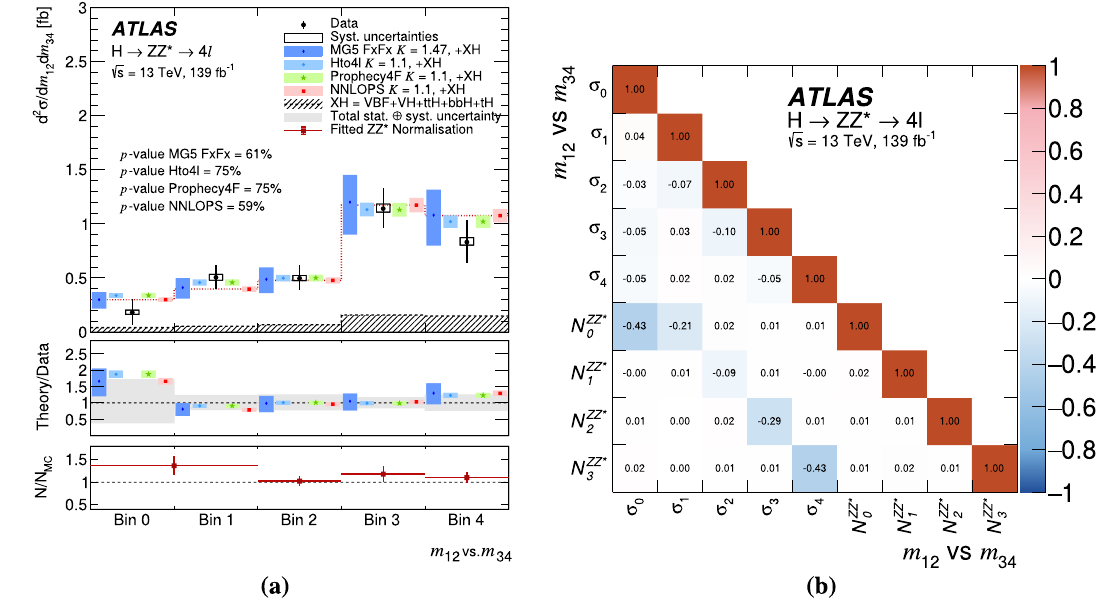
Fig. 31 a Differential fiducial cross section for the leading vs. subleading Z boson mass, m 12 vs. m 34 , and b the corresponding correlation matrix between the measured cross sections and the Z Z ∗ background normalisation factors. The bin boundaries are defined in Fig.